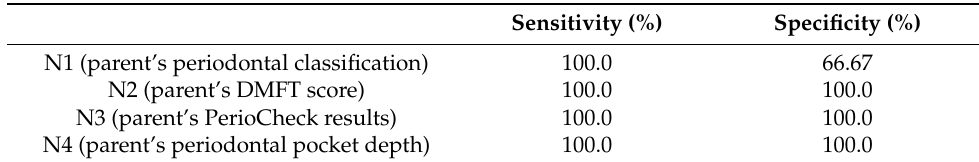
Table 4. Sensitivity and specificity for variables identified using the DT for the prediction of caries outcome (dmft) in